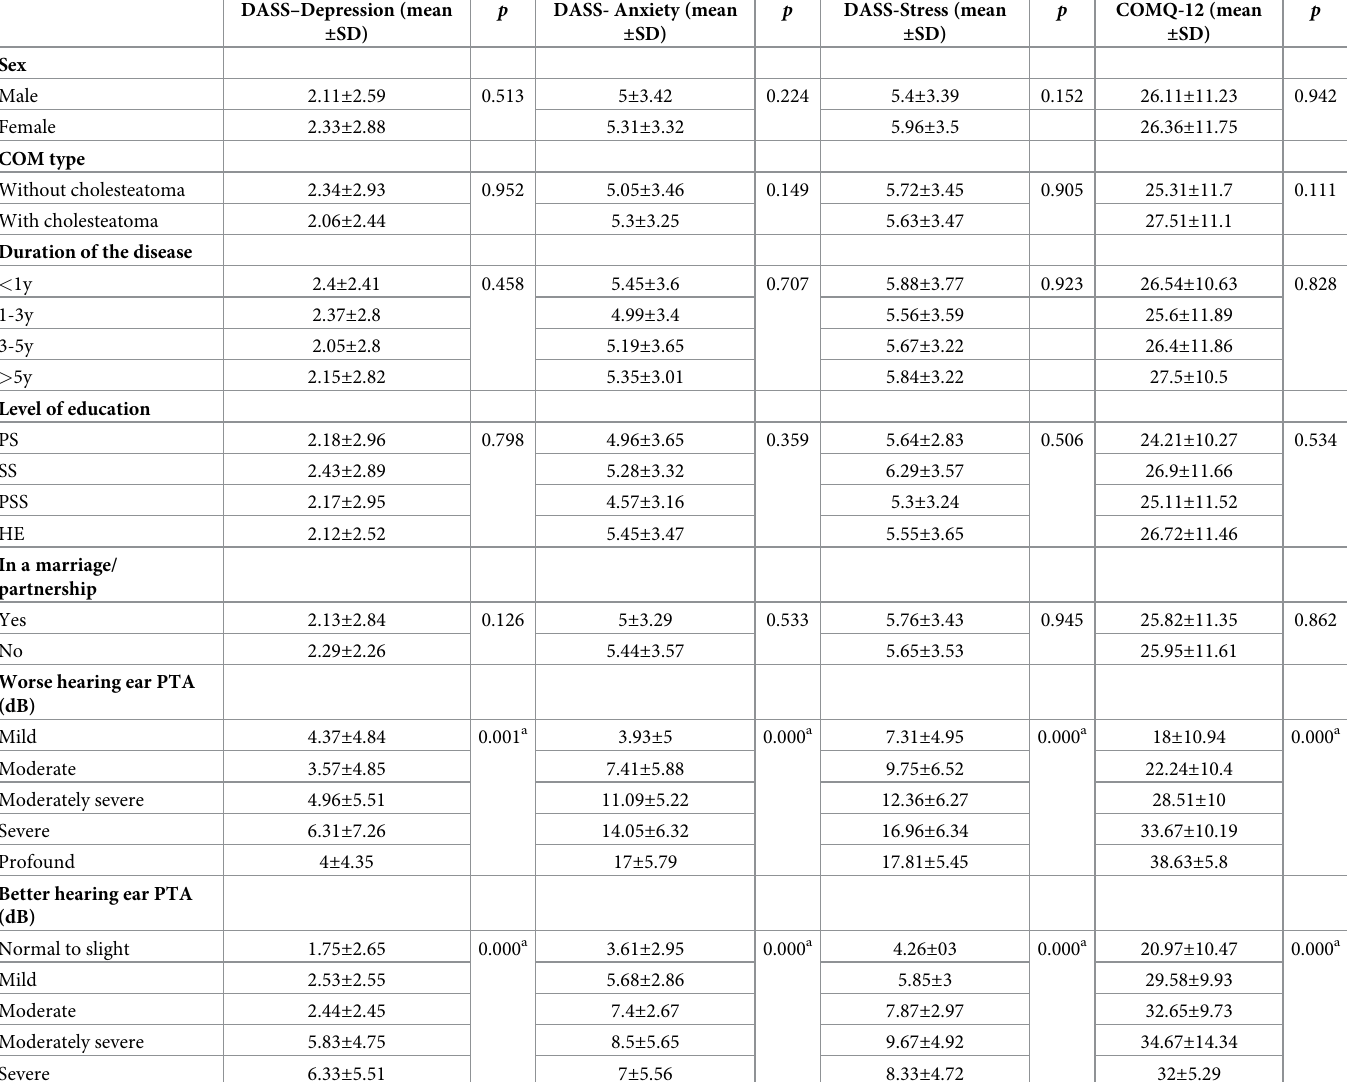
Table 2. DASS-21 subscale scores and COMQ-12 scores according to patient’s